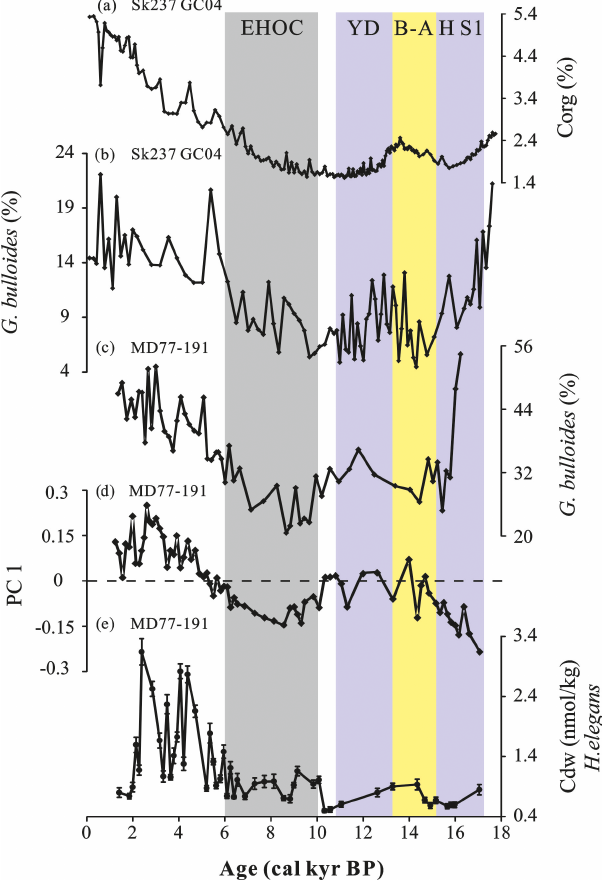
Figure 5. (a) Organic carbon weight percentage (%C org ) and (b) G. bulloides percentage from core SK237 GC04 (1245m, Ara- bian Sea, Naik et al., 2017). (c) Relative abundance of G. bulloides (Mléneck, 1997; Bassinot et al., 2011), (d) PC 1 scores and (e) Cd w records from core MD77-191 (Arabian Sea). The color-shaded in- tervals and abbreviations are the same as in Fig.